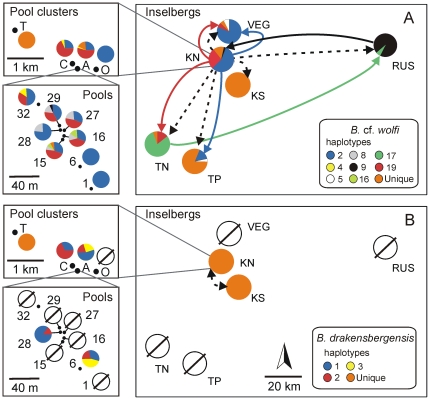
Haplotype distributions indicating long distance dispersal events.Geographic distribution of haplotypes of (a) Branchipodopsis cf. wolfi and (b) Branchipodopsis drakensbergensis among inselbergs (right), among the different pool clusters on Korannaberg North (top left) and among different pools within pool cluster A on Korannaberg North (bottom left). Pie charts depict relative abundance of haplotypes at each site. The proportion of haplotypes unique to a certain locality is highlighted in orange. A Ø symbol indicates that the respective species was not found at this locality. Arrows indicate long distance dispersal events detected in our analyses. Dashed arrows mark initial colonization events based on the topology of the haplotype network, colored arrows illustrate more recent migration evidenced by haplotype sharing. Direction of dispersal could not be determined for haplotypes 5, thus no arrow was plotted.